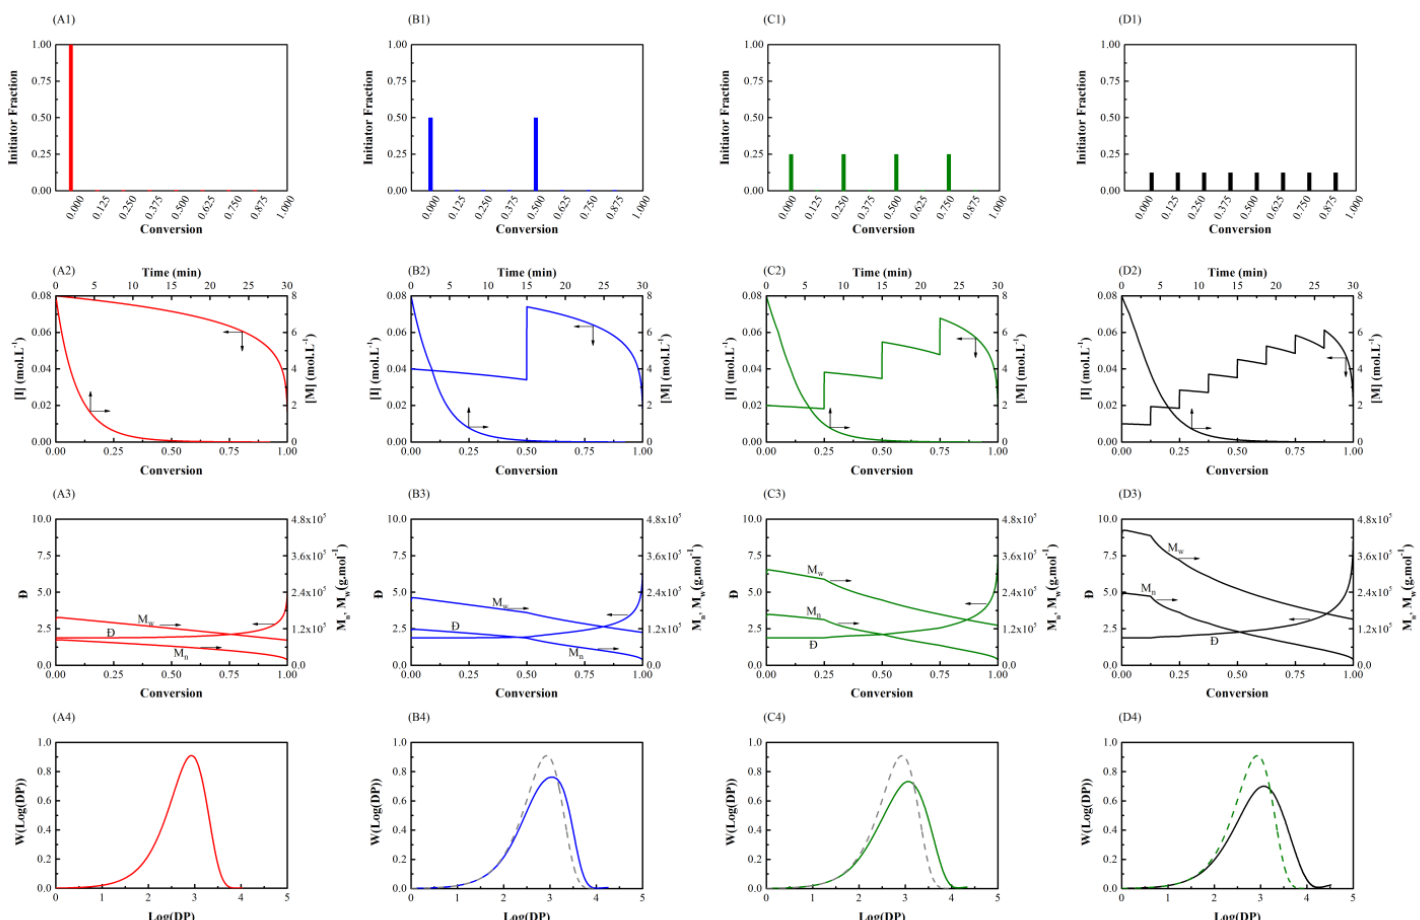
9 Figure 1. Semi-batch general free radical polymerization (Case 1) using di ff erent number of shots (NOS) feeding policies with initial values [ M ] = 8.00 mol L –1 and 0 = 0.08 mol L –1 . First row: initiator feeding policy for NOS-1 (A [ I ] 1 ), NOS-2 (B 1 ), NOS-3 (C 1 ), and NOS-4 (D 1 ). Second row: total monomer and initiator conversion 0 for NOS-1 (A 2 ), NOS-2 (B 2 ), NOS-3 (C 2 ), and NOS-4 (D 2 ). Third row: number- and weight-average molecular weight and dispersity versus conversion for NOS-1 (A 3 ), NOS-2 (B 3 ), NOS-3 (C 3 ), and NOS-4 (D 3 ). Fourth row: final molecular weight distribution for NOS-1 (A 4 ), NOS-2 (B 4 ), NOS-3 (C 4 ), and NOS-4 (D 4 ) (solid line), the latter three also presenting the A 4 result (dashed line) for